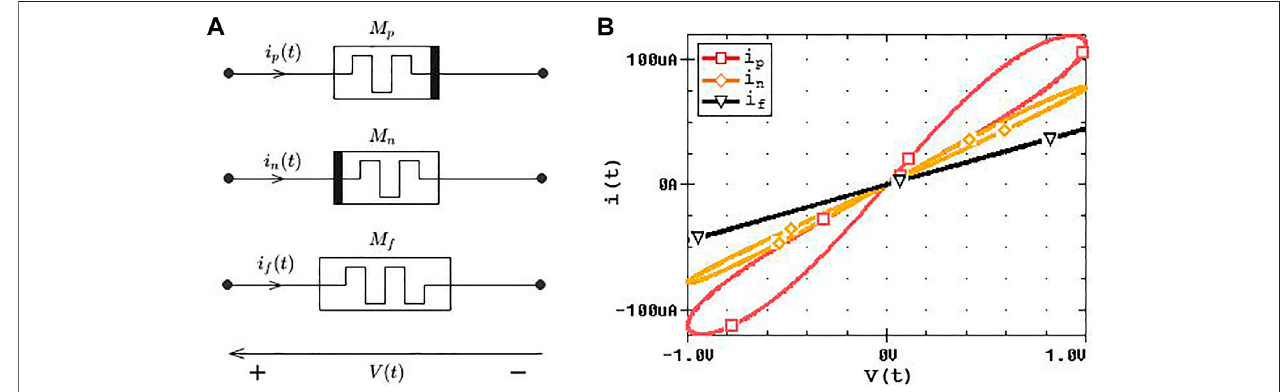
FIGURE 11 | Circuit response comparison of a memristor fuse with standalone memristors. (A) Circuit schematic with a sine input voltage source. M p is the memristor with positive polarity preference, M n is with negative polarity preference, and M f is the memristor fuse; (B) current – voltage characteristics for M p (red), M n (orange), and M f (black).